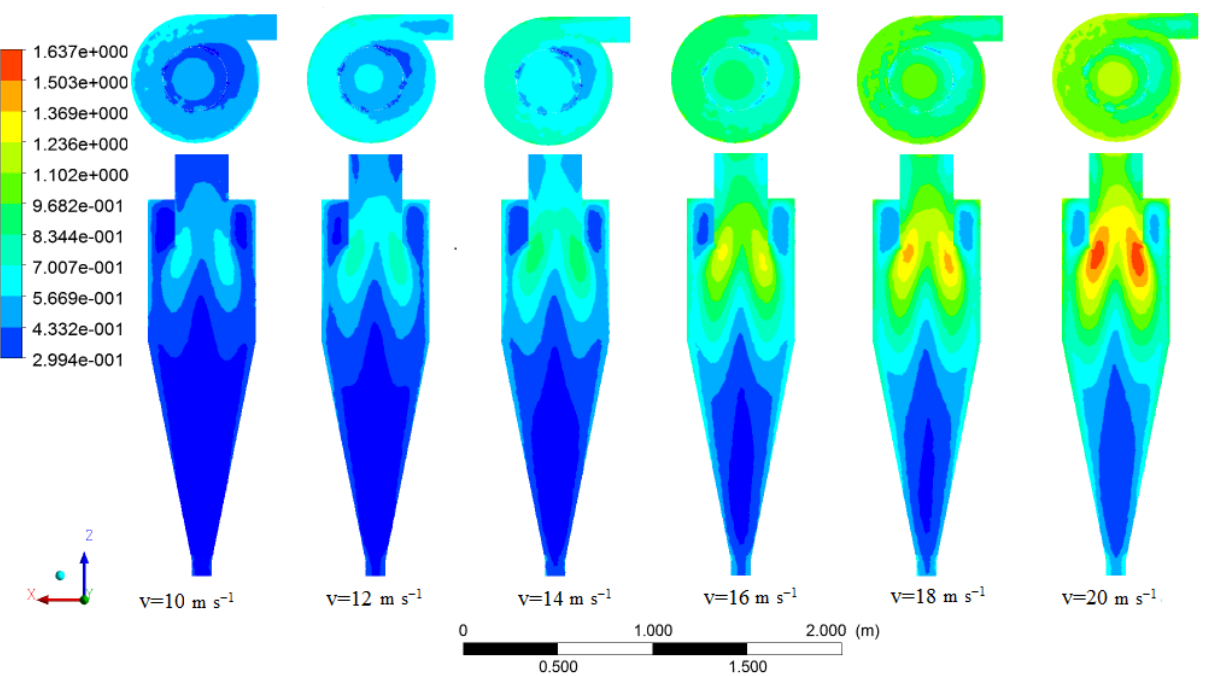
Figure 12. Turbulent intensity contours in various inlet velocities.